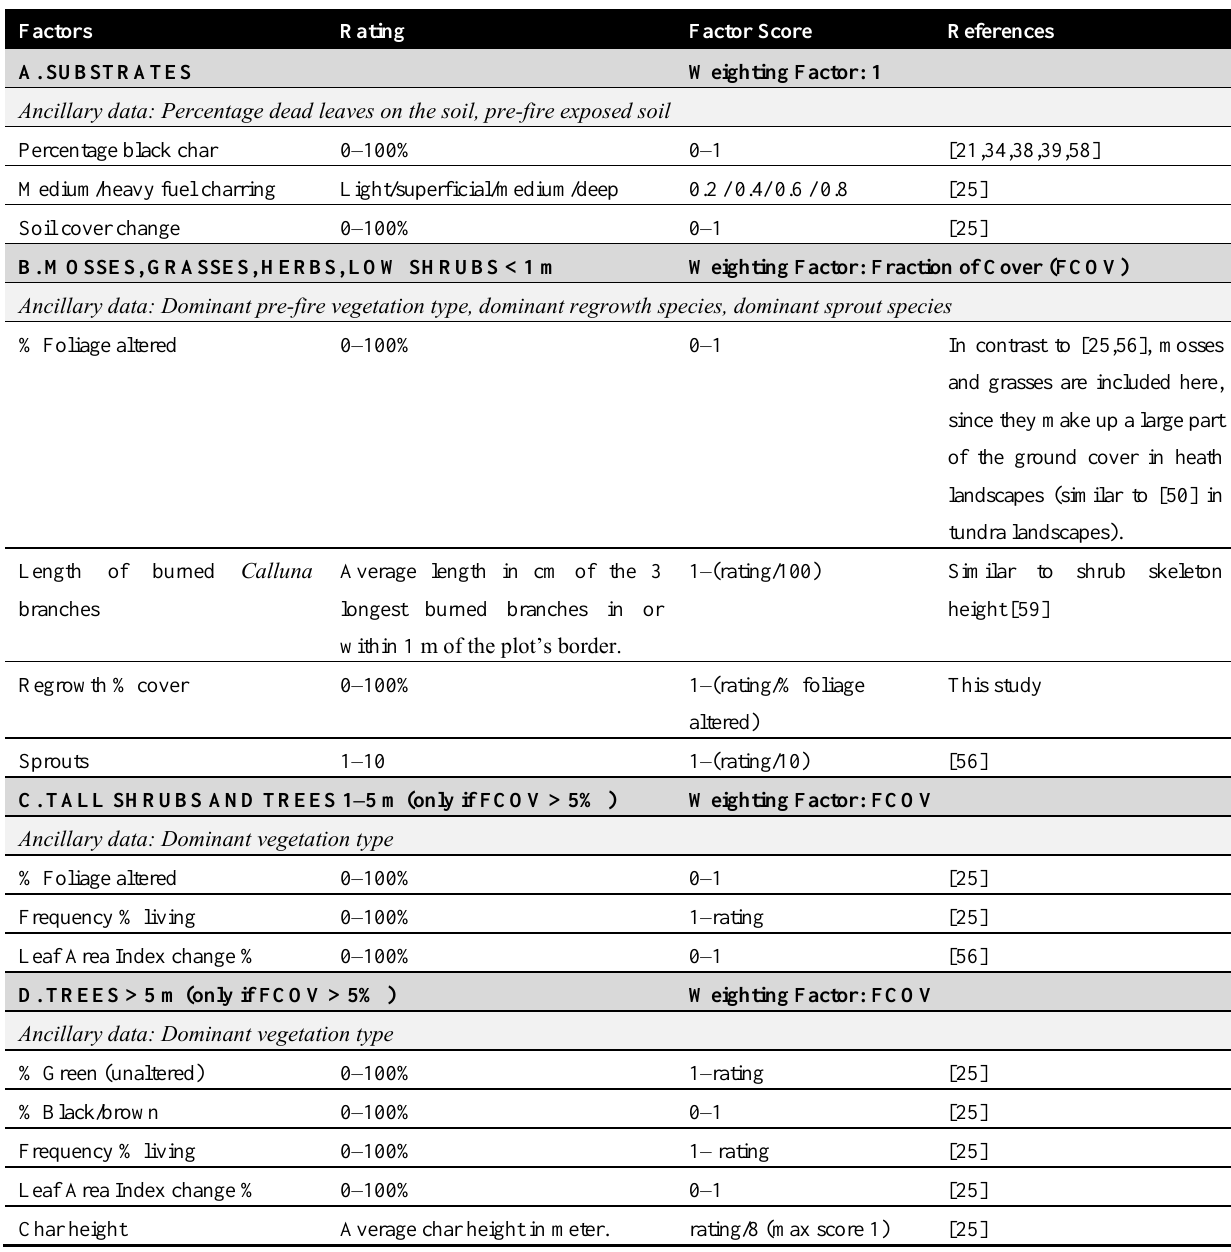
Table 1. Modified Geometrically structured Composite Burn Index (GeoCBI) for heathlands used in this